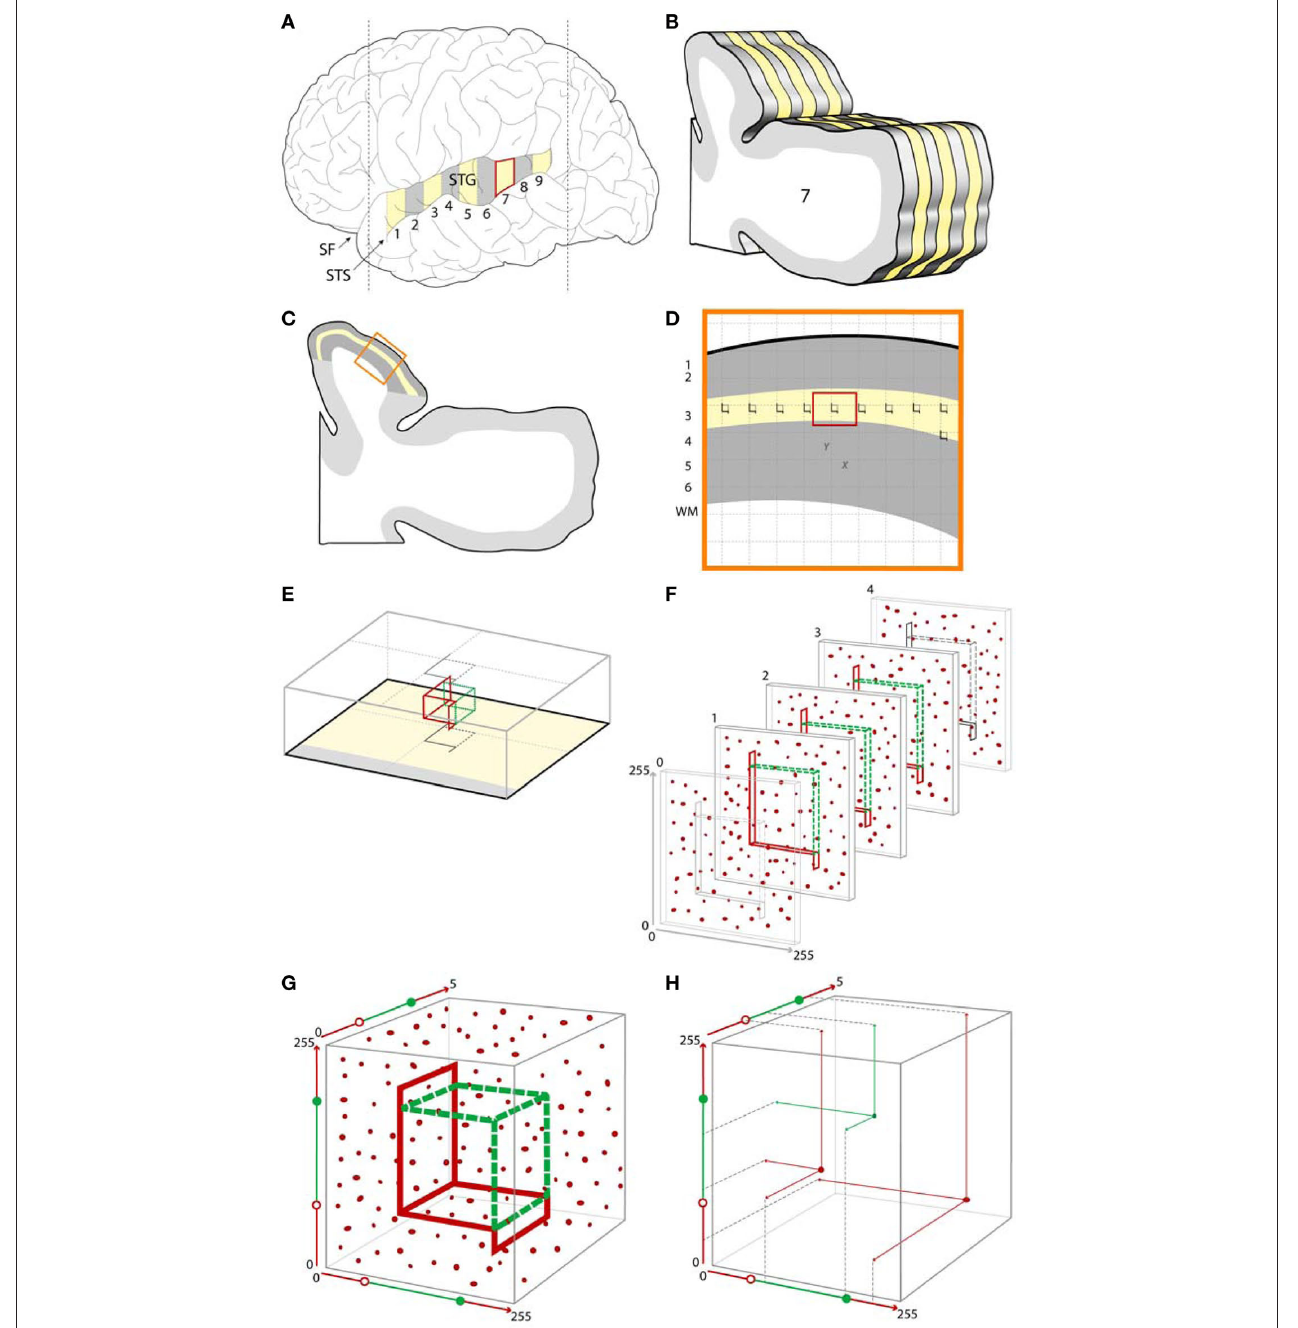
the tissue section. The gray outlines represent the projections of the disector unto the superficial and deep surfaces of the tissue section. (F) A series of 2D confocal images at a fixed distance apart in the z -axis (see Other Technical Issues for a discussion of appropriate z -axis sampling distances) are collected at each sampling site. Immunoreactive synaptic structures are shown as red puncta. (g) The series of images are combined to form a 3D data set from each site, resulting in a sampled cube with x and y dimensions represented here in pixels and the z dimension as plane number. Within this data set, the disector can be conceived of as defined by a set of values in 3D. (H) Using the masking approach described above, a center of volume, that is a single point defined by x , y , z coordinates, can be assigned for each immunoreactive puncta. Puncta with centers of volume falling within the boundaries of the optical disector are sampled for quantification (shown here in green), while those puncta with centers of volume falling outside the disector, or touching one of the exclusion lines (red) are not selected for quantification. SF, Sylvian fissure; STS, superior temporal